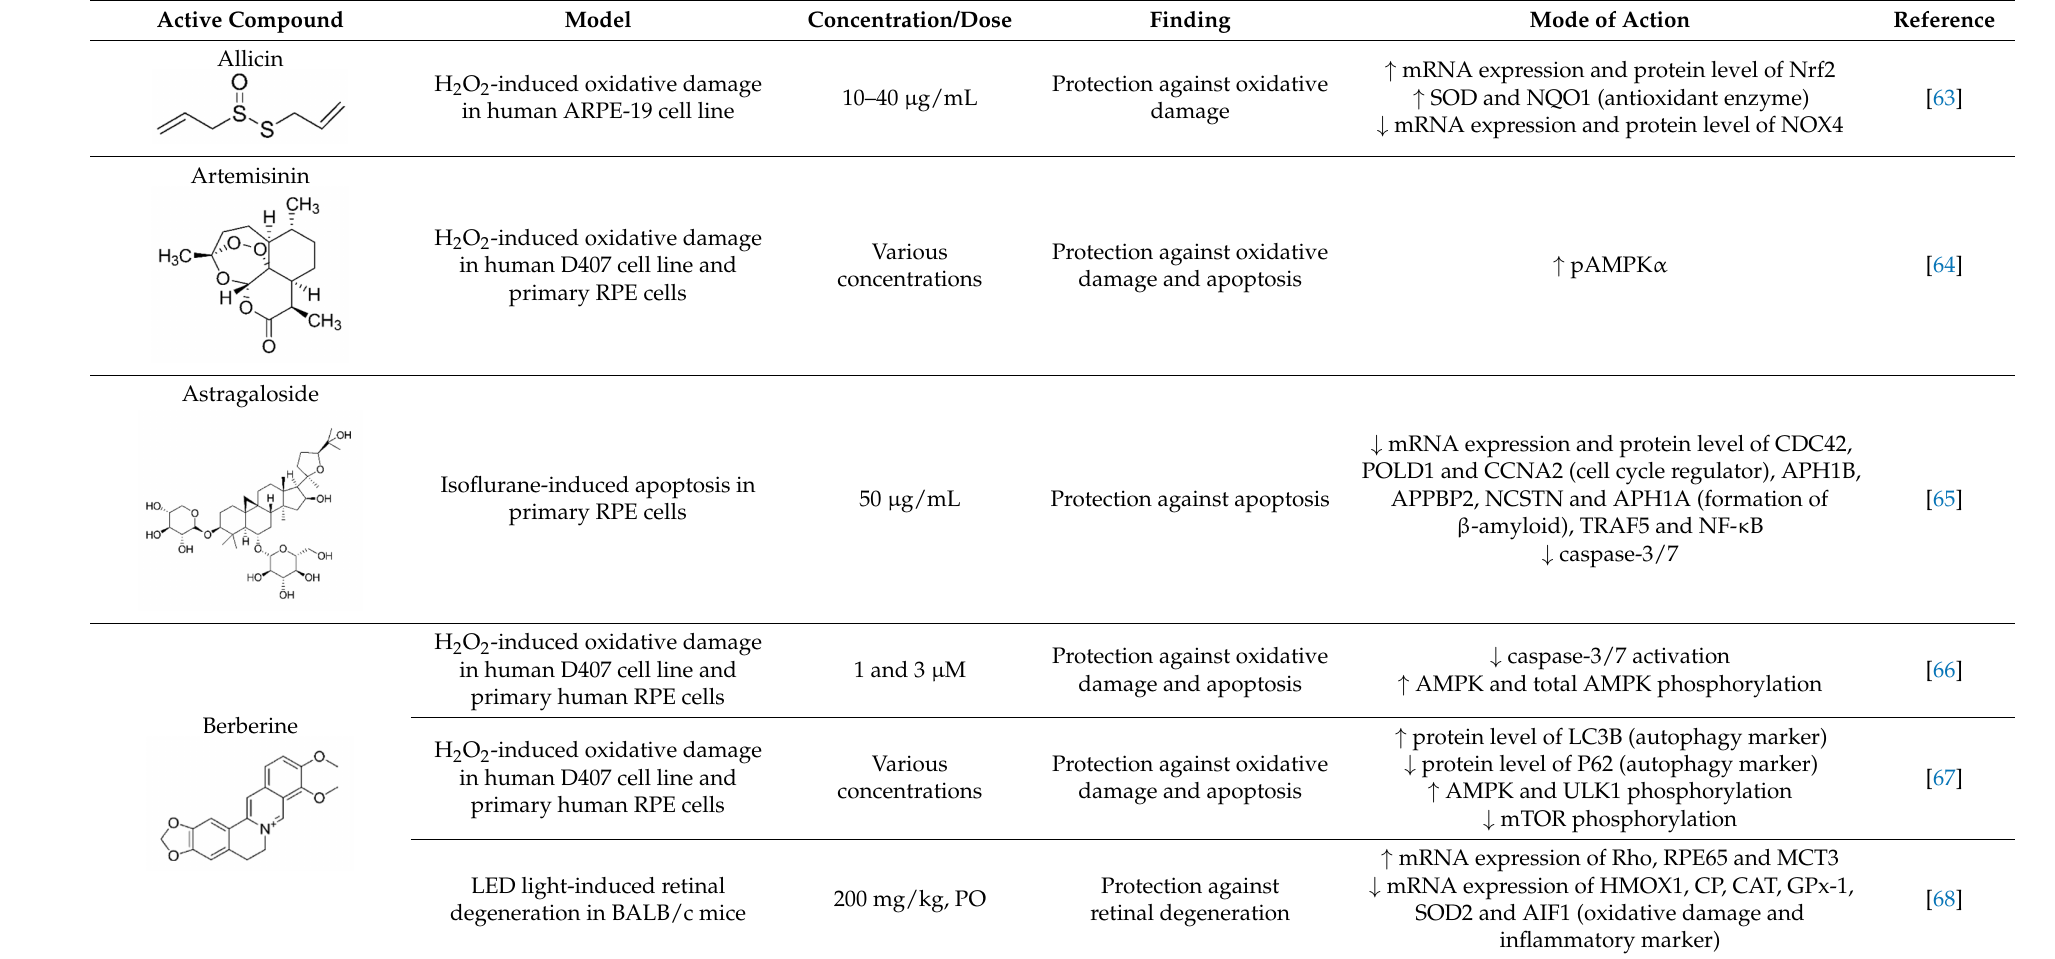
Table 1. Active compounds in the alleviation of